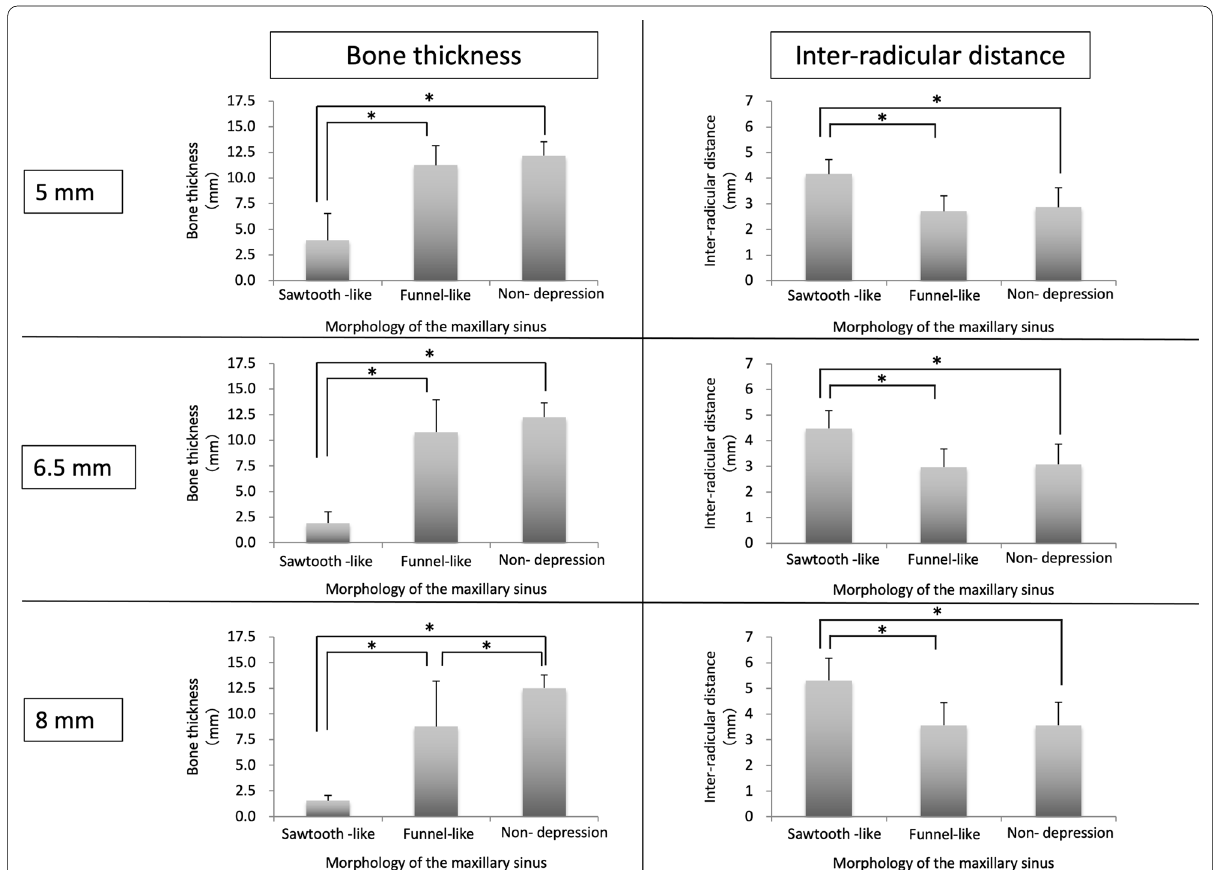
Fig. 4 Comparison of buccolingual bone thickness and inter-radicular distance between the three sinus morphology types at 5, 6.5, and 8 mm from the alveolar crest between the maxillary second premolar and first